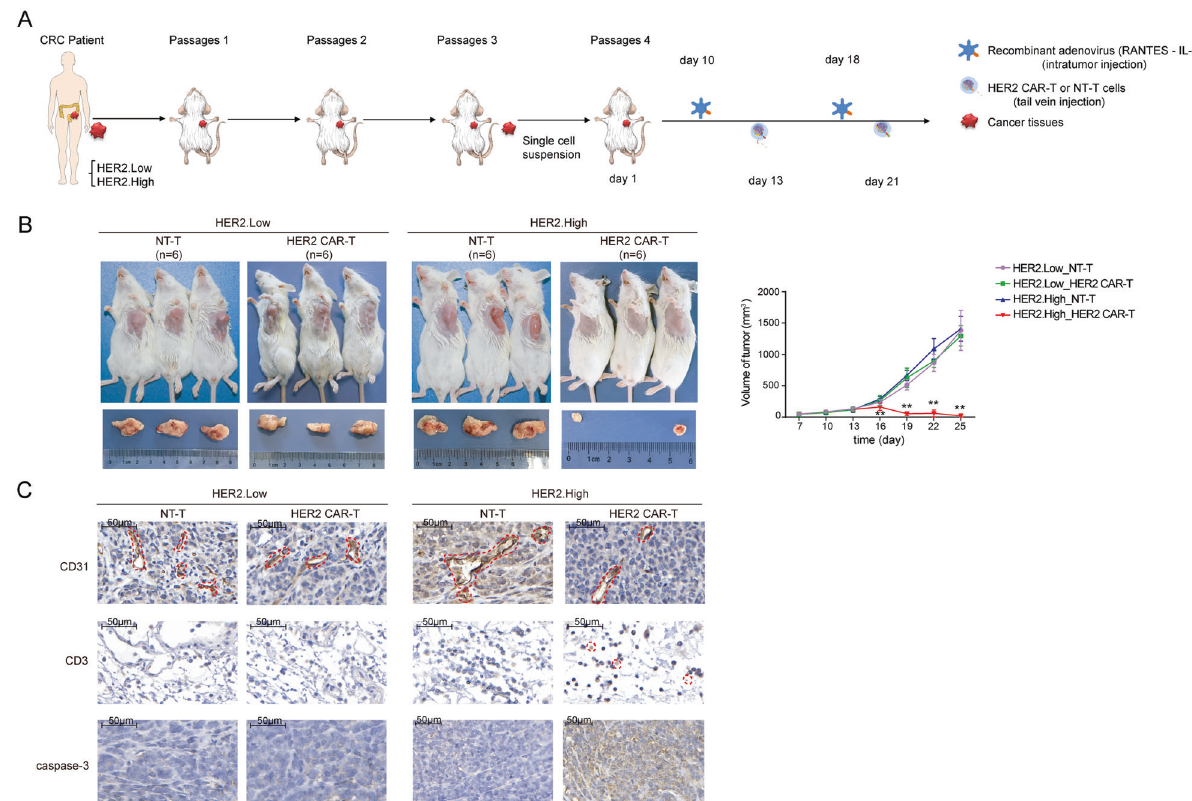
Fig. 5 HER2 CAR-T cells display greater aggressiveness in HER2 + CRC in PDX models. A Left panel: Fresh human CRC tissues were transplanted into NCG mice. After three passages, a singlecell suspension of the PDX tumor cells (HER2.Low: low expression of HER2, HER2. High: high expression of HER2) was obtained. Right panel: Schematic of the PDX models ( n = 24). NCG mice were injected subcutaneously with single-cell suspension on day 1, and recombinant adenovirus was injected on days 10 and 18. HER2 CAR-T or NT-T cells (1 × 10 7 ) were injected via a tail vein on days 13 and 21, respectively. B The volume of the tumor was measured twice a week (** P < 0.01, HER2 CAR-T compared with NT-T in HER2.High group, two-tailed t -test). C The protein levels of CD31, CD3, and caspase-3 in mice were evaluated by IHC, and the representative images are shown. The scale bar is marked in each image.